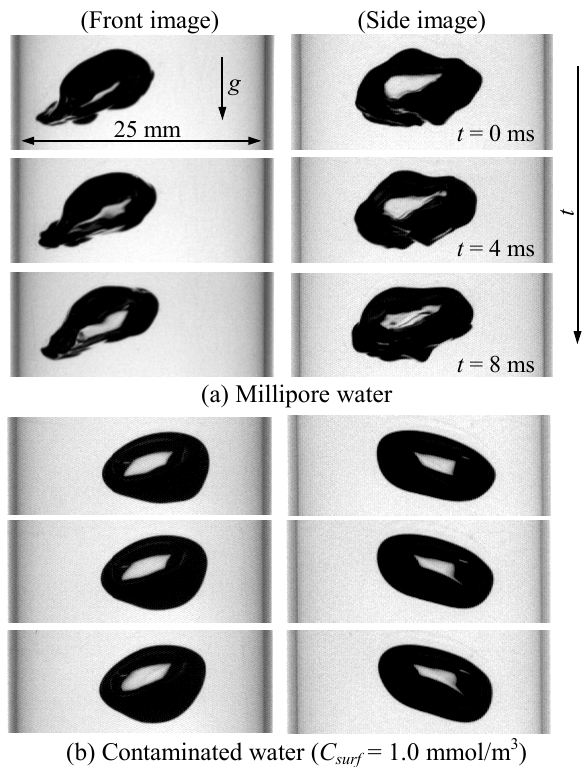
Fig. 9 Sequential images of a bubble ( d = 9 mm) in Millipore water and in contaminated